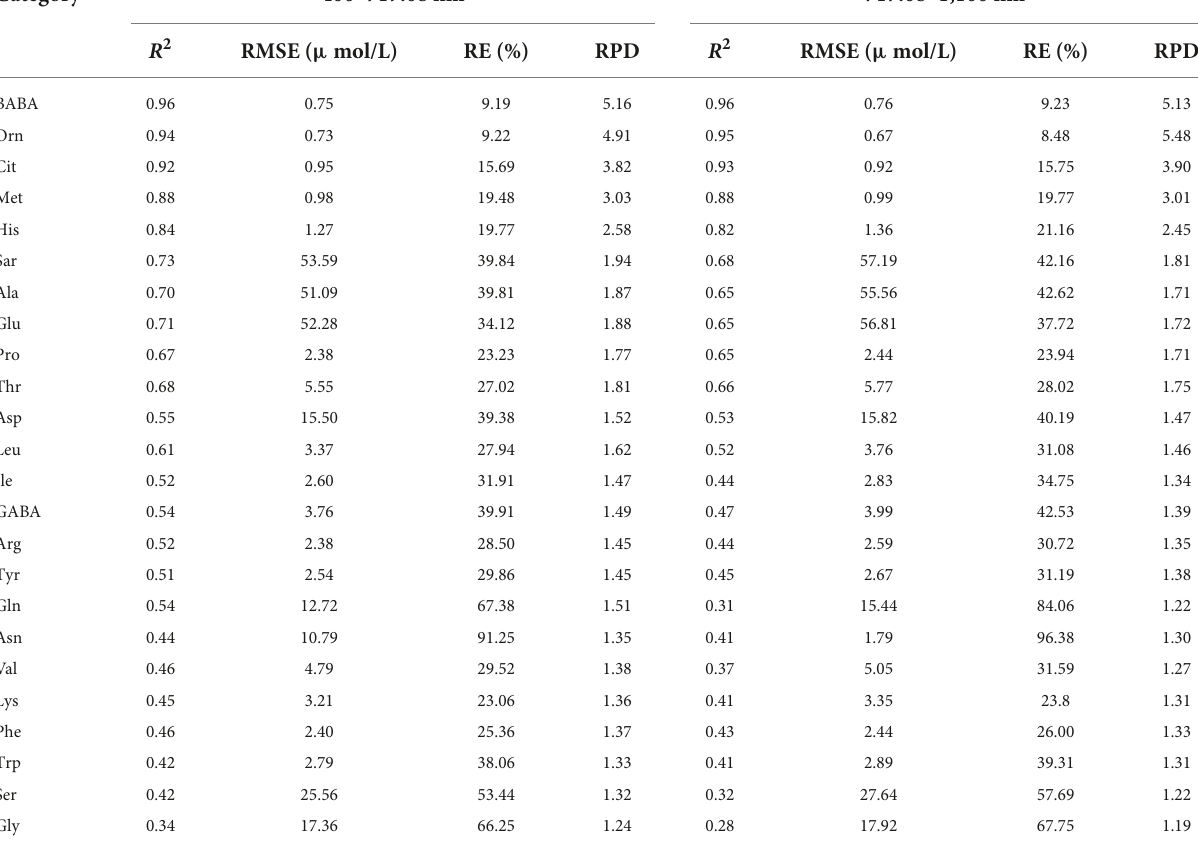
TABLE 3 Evaluation results of PLSR model using test set for various amino acid contents based on the reflectance of band